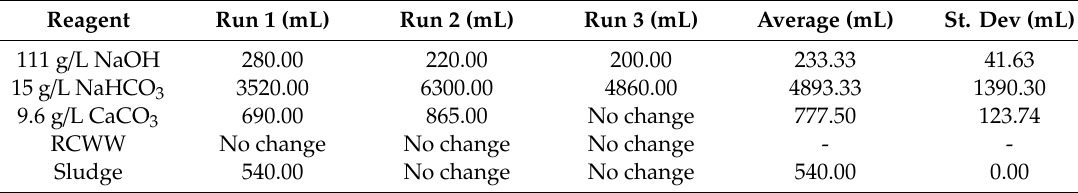
Table 5. Titrations to investigate most e ffi cient reagent to increase pH of product (titrand = 40